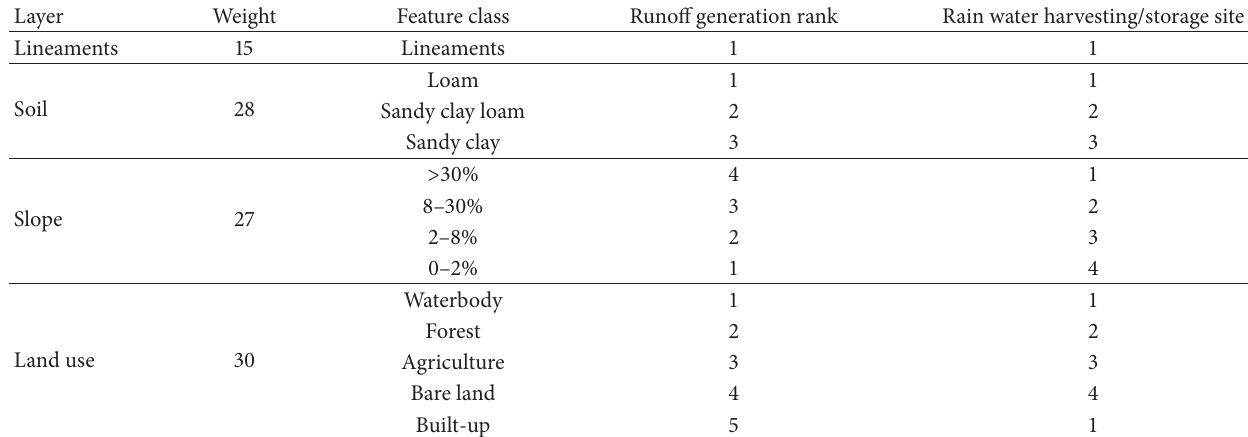
Table 2: Weightage and ranking for